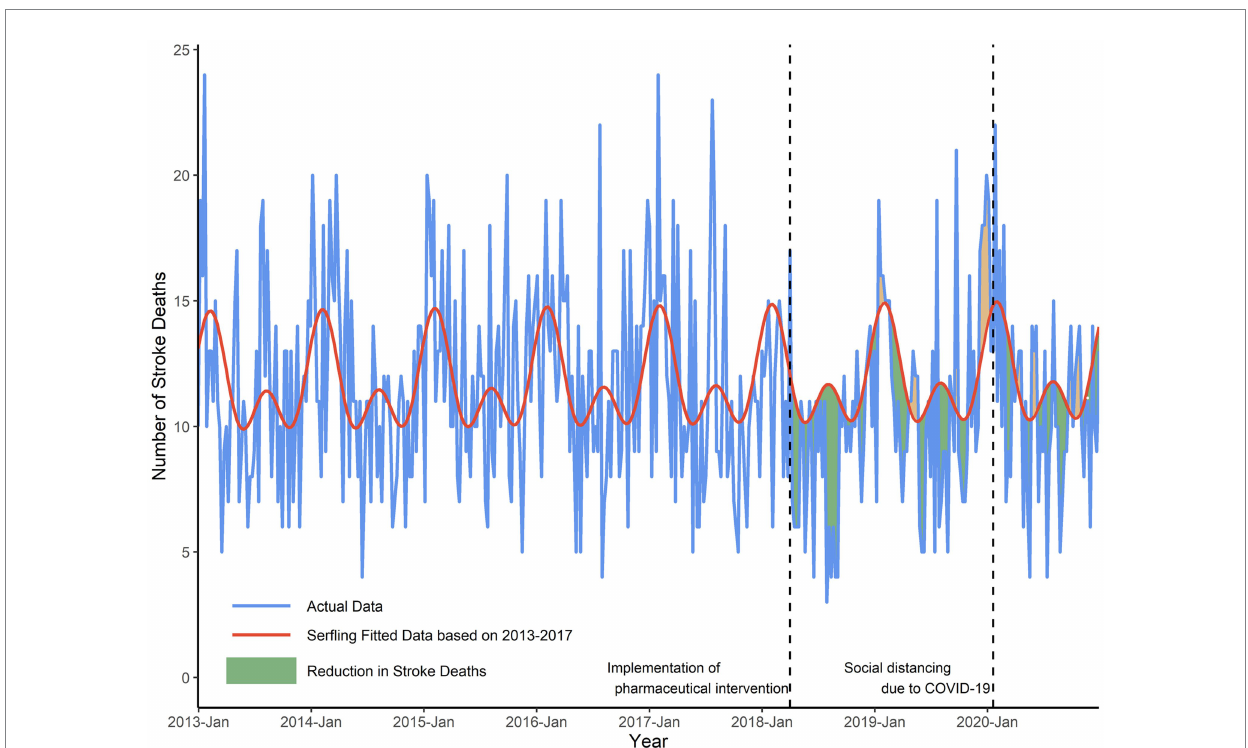
FIGURE 1 Number of weekly stroke deaths in Deqing, 2013–2020. Blue line depicted actual number of stroke deaths per week from January 2013 to December 2020. Red line predicted trends of stroke deaths using Serfling regression model based on 2013–2017 historic data in the counterfactual world in which pharmaceutical and non-pharmaceutical intervention were not implemented. Green shadows were presented as the reduction in stroke deaths, indicating those timepoints when actual number of stroke deaths was less than predicted number of deaths after the free hypertension pharmacy program. The dashed vertical lines showed the time when the free pharmaceutical intervention program in Deqing (April 1, 2018) and large-scale social distancing due to the pandemic of COVID-19 (January 20, 2020) were